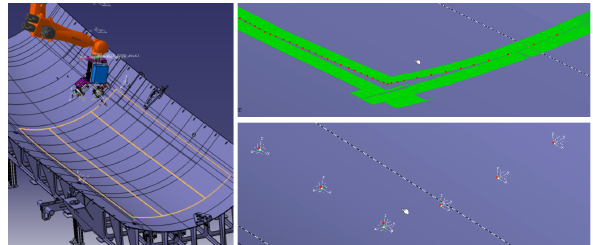
Figure 2: Edge detection with LLS in the virtual environment of the MFZ, © DLR